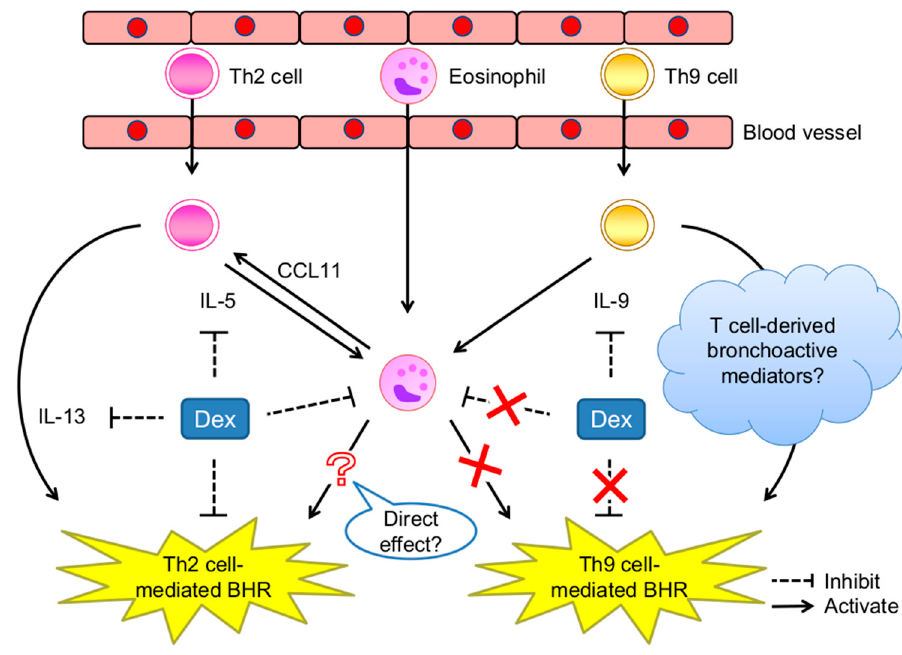
Figure 1. Schematic mechanisms of eosinophil-independent and steroid-resistant bronchial hyperresponsiveness (BHR) mediated by Th9 cells compared with Th2-mediated responses. 6. Th9 Cells Induce BHR Accompanied by but Not Dependent on Eosinophil